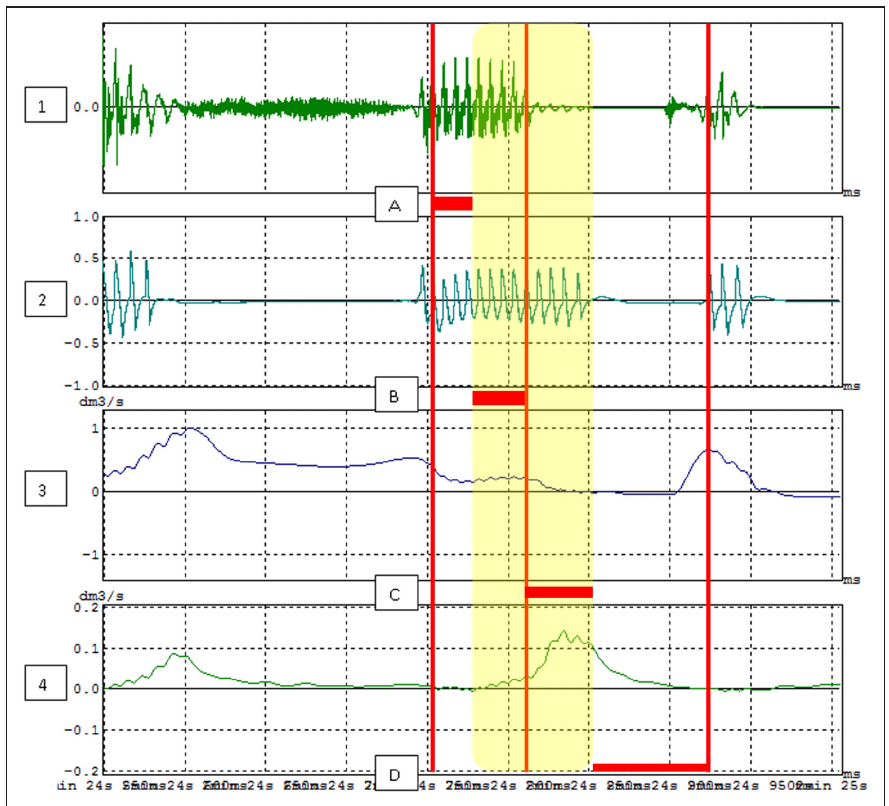
Figure 2: Alignment of the four signals used to mark the segments of interest in the word senta : (1) speech signal, (2) electroglottogram, (3) oral airflow, (4) nasal airflow. Vertical red lines indi- cate the beginning and end marking of the vowel and the consonant; the yellow band indicates the marking of the nasalized portion of vowel and consonant. Horizontal red lines indicate (A) the oral portion of the vowel, (B) the nasalized portion of the vowel, (C) nasal murmur, and (D) consonant oral